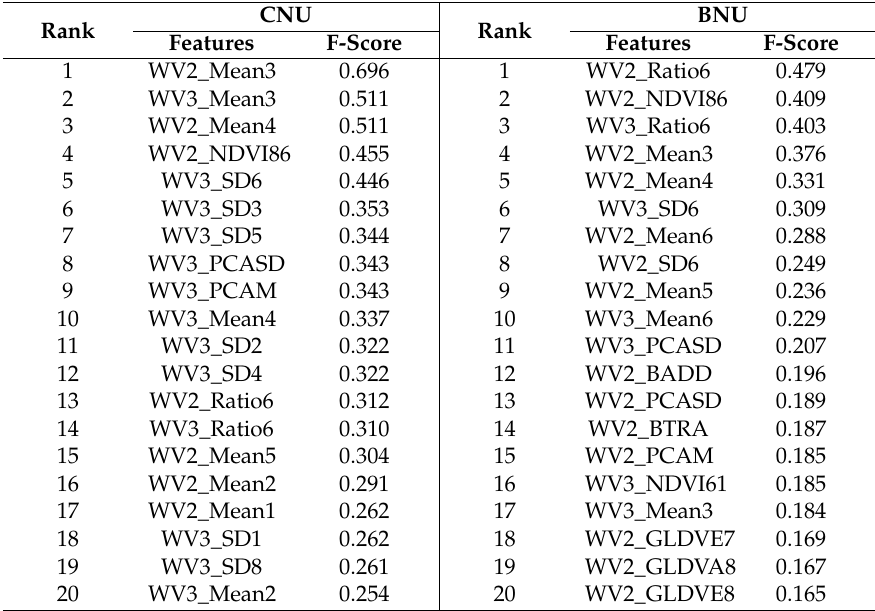
Table 8. F-score weight of each feature in SVM for bi-temporal classification. CNU Rank Rank